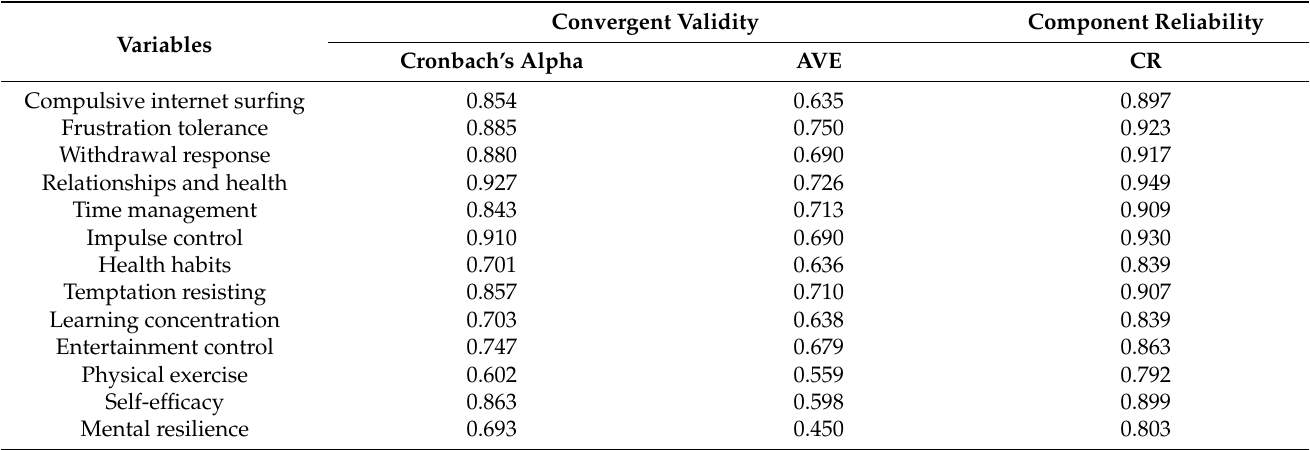
Table 1. Reliability tests for each